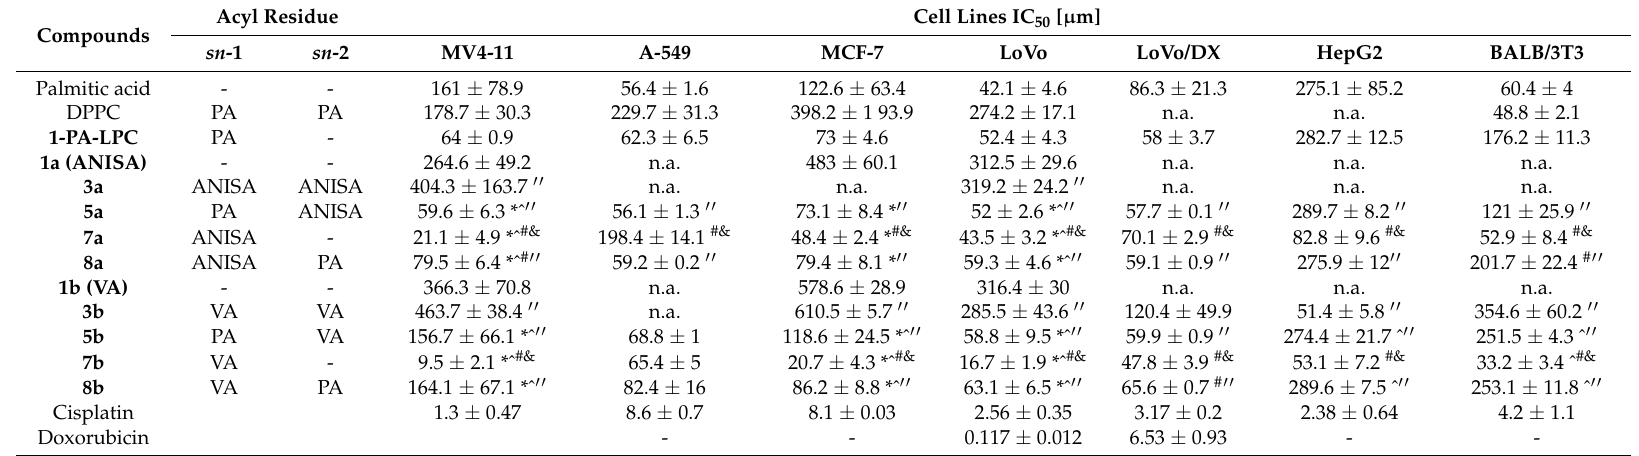
Table 1. Antiproliferative activity of phenolic-phospholipids against human cancer cell